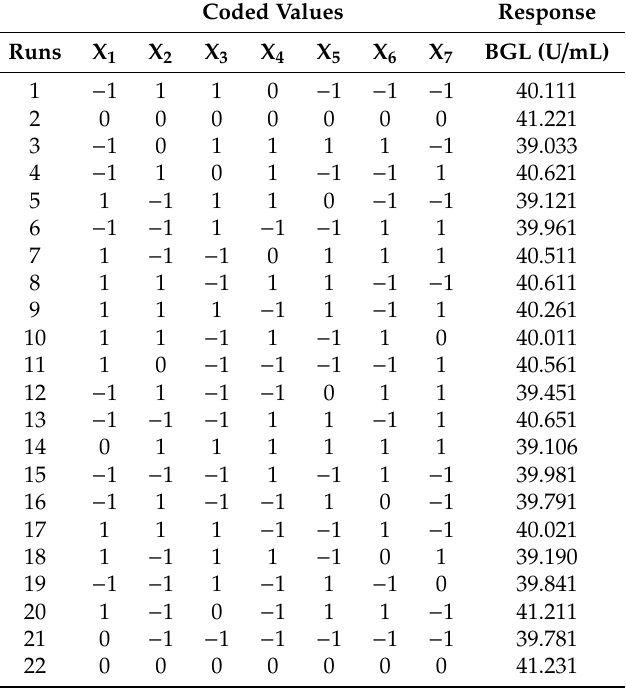
Table 4. Definitive Screening Design. Multiple screening designs for identification of most influential factors on the production of S.griseus recombinant β -glucosidase. It depicts coded values of the designs, along with the observed experimental response ( β -glucosidase activity (BGL); U /